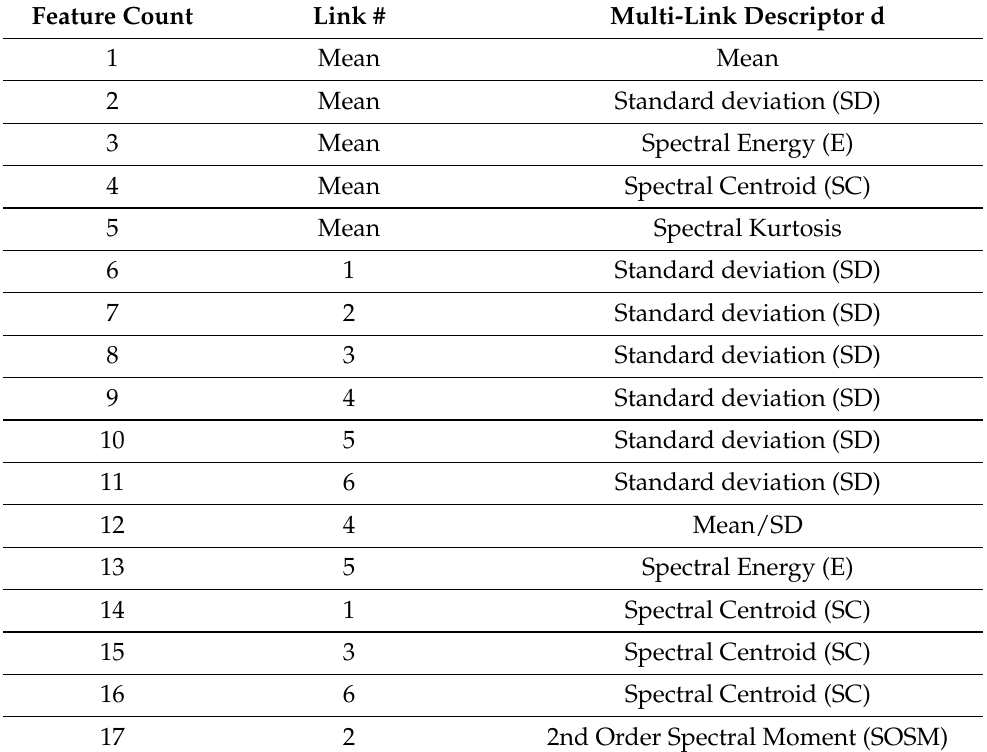
Table 3. Features selected by multicollinearity method.